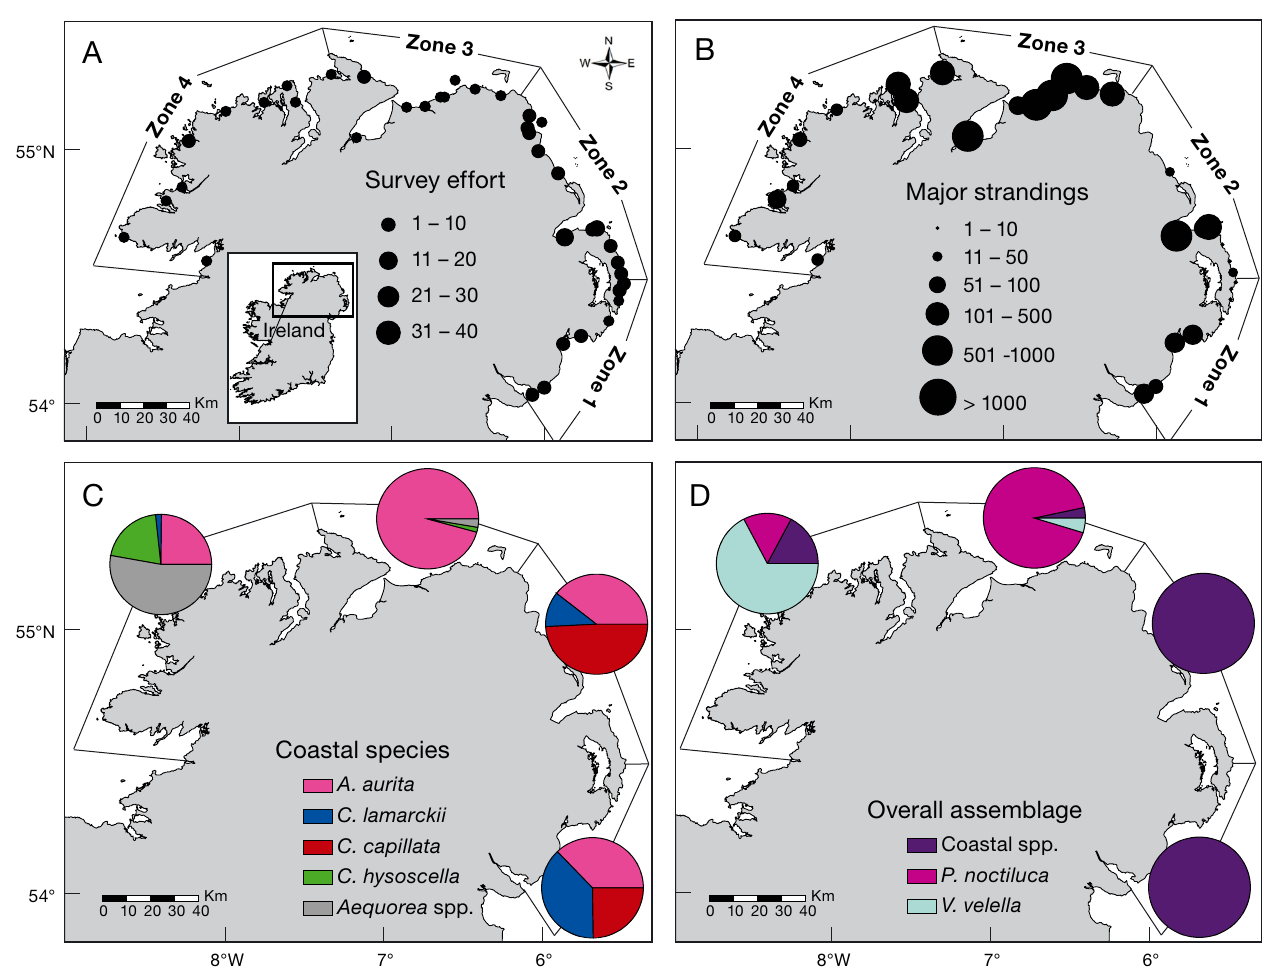
Fig. 1. (A) Survey effort (number of times a beach was surveyed between 2009 and 2011) and the 4 zones (each consisting of 10 beaches) classified according to their proximate body of water: Zone 1, Irish Sea; Zone 2, North Channel; Zone 3, ap- proaches to the North Channel; Zone 4, Atlantic. (B) Areas most vulnerable to major stranding events, with Zones 3 and 4 most affected by Pelagia noctiluca , and Zones 1 and 2 by Cyanea capillata . (C) Numerical contribution of different coastal jelly fish species from 2009 to 2011 (oceanic jellyfish excluded from the total number of stranded individuals). (D) Proportional contribution of all jellyfish species to the total number of stranded individuals, highlighting the predominance of P. noctiluca along the coastline facing the Atlantic (Zones 3 and 4). All species names are given in Table